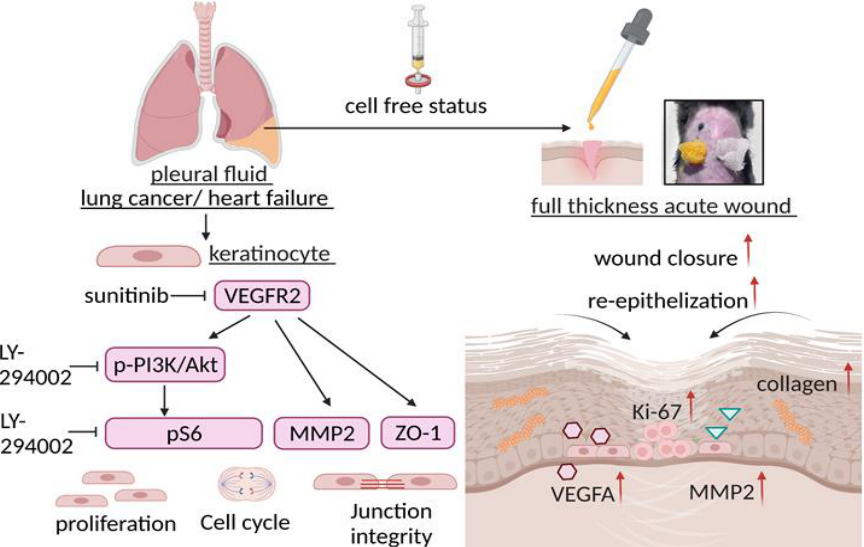
Figure 10. Scheme of LCPF-induced, early cutaneous wound healing and keratinocyte proliferation. Representative images of a mouse cutaneous wound with wet wrap therapy. The left side shows the wet dressing with LCPF and the right shows 0.9% saline as the control.